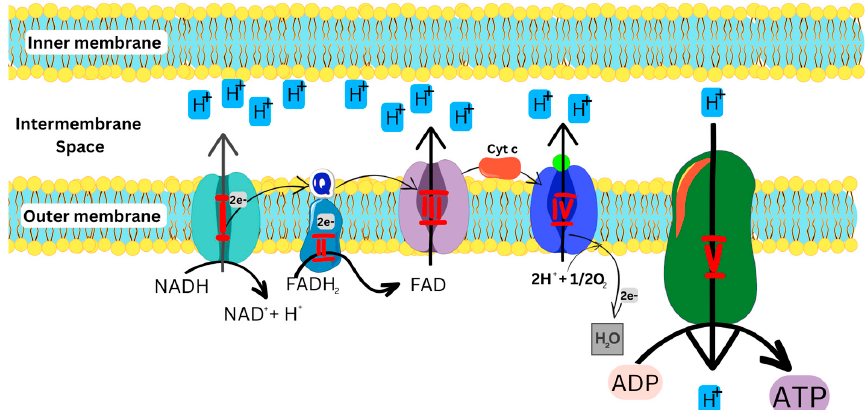
Figure 2. OXPHOS pathway, showing the transfer of electrons in the ETC to produce ATP. NADH: Reduced nicotinamide adenine dinucleotide; FADH: Reduced flavin adenine dinucleotide; ADP: Adenosine diphosphate; ATP: Adenosine triphosphate.